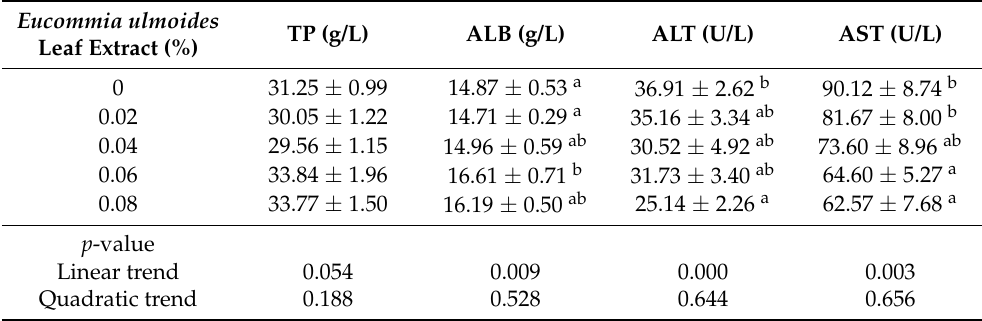
Table 6. Plasma parameters of the GIFT fed with different